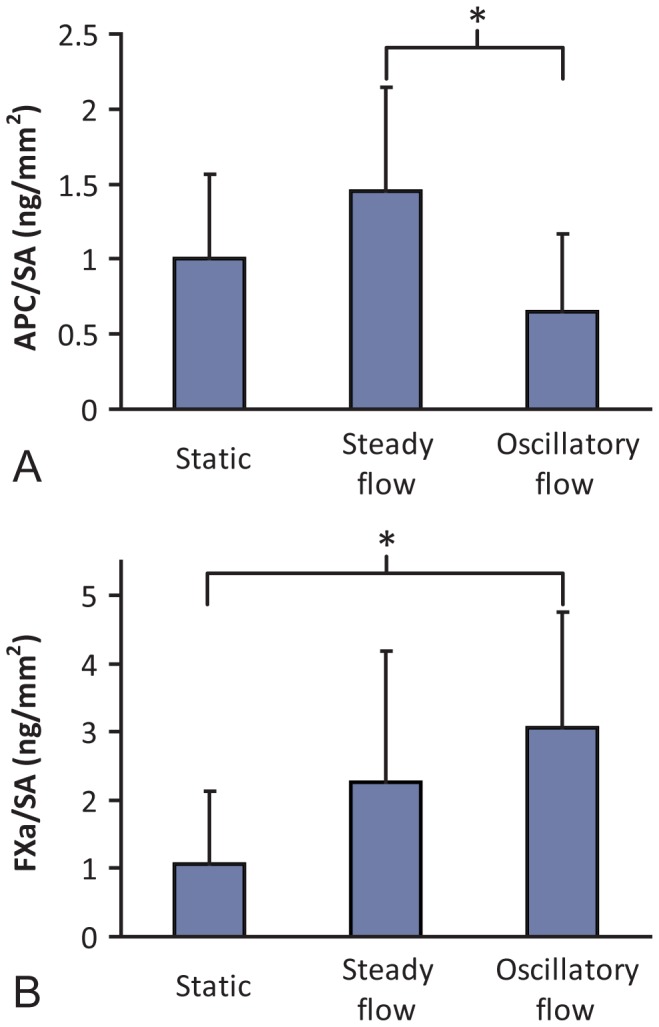

In vitro functional data.Quantification of APC and FXa production by EOCs seeded onto ePTFE grafts and stimulated with steady fluid shear stress, oscillatory shear stress, or continued static culture for 24hrs after 24hrs of initial seeding. APC production per surface area (SA) was significantly higher in the steady flow treated sample when compared to the oscillatory flow treated sample (A) (*p = 0.05). FXa production per surface area was significantly higher in the oscillatory treated sample compared to the no flow control (B) (*p = 0.01). ANOVA, N≥6.